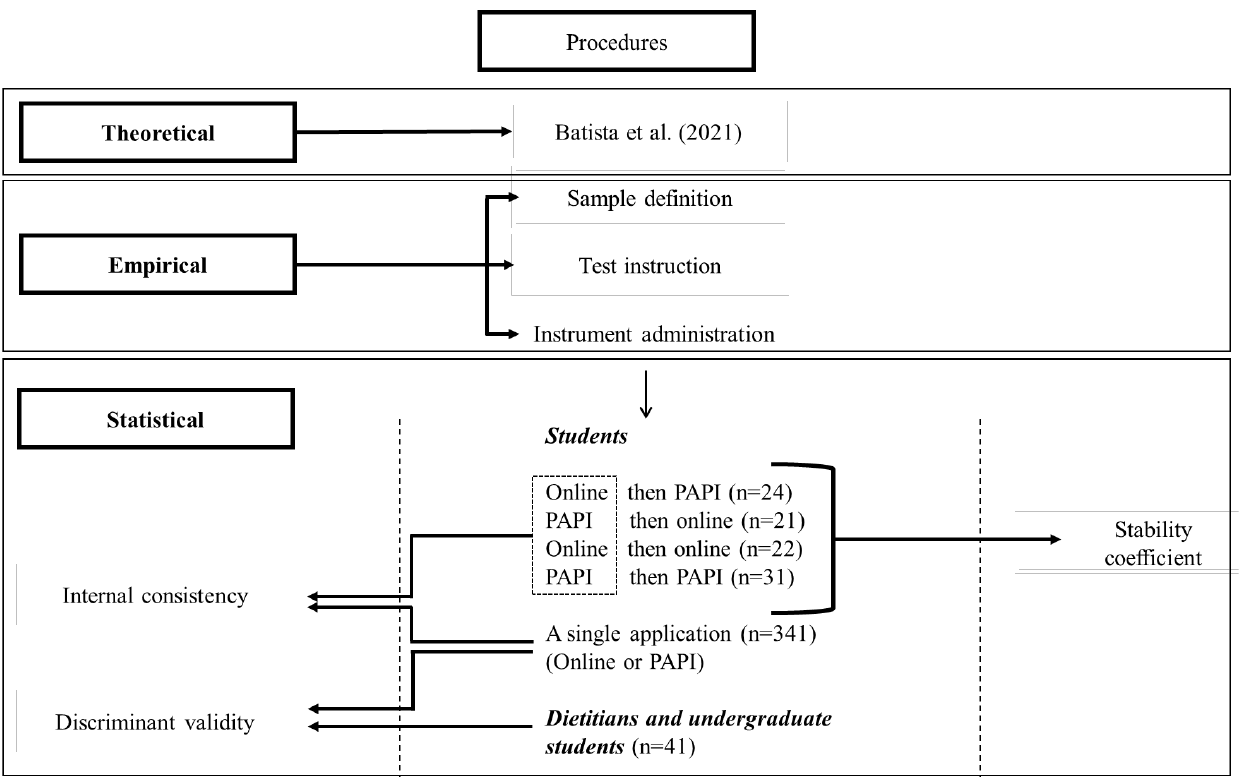
Figure 1. Steps for instrument validation.